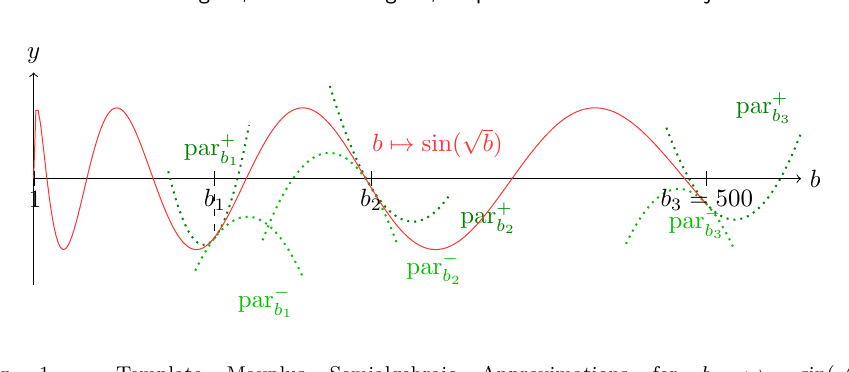
Fig. 1. Template Maxplus Semialgebraic Approximations for b 7→ sin( √ max j ∈{ 1 , 2 , 3 } { par − ( x i ) } (cid:54) sin x i (cid:54) min j ∈{ 1 , 2 , 3 } { par + ( x i ) } b j b j | · | 2 is convex on I (for more details γ , i.e. the univariate function g := r + γ 2